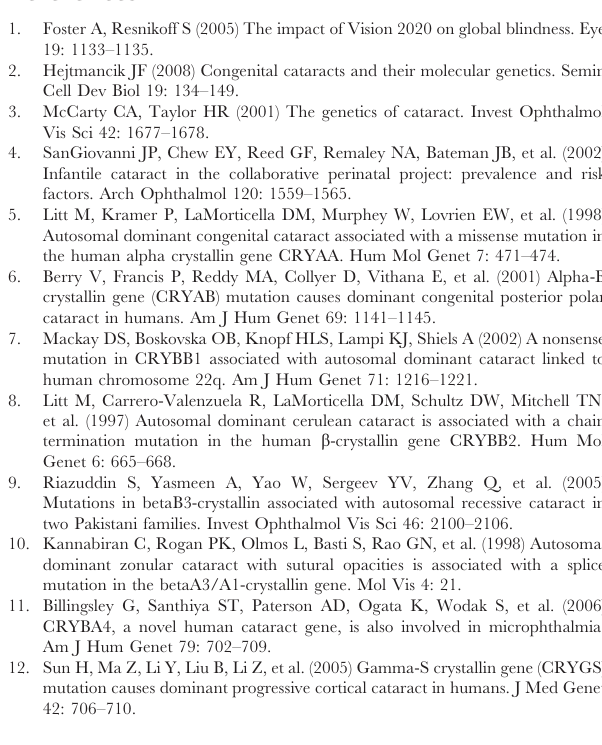
conditions at 24 or 48 hours. ***, P , 0.001; **, P , 0.01; *, P , 0.05; and ns, not significant. Values of P , 0.05 were considered to be statistically significant. Figure S5 Ligand-stimulated EPHA2 activation regu- lates Akt activation in a TN4-1 cells. ( A ) Mutant EPHA2 genes have reduced ability to activate Akt. a TN4-1 cells were grown to near confluence, and growth factor-starved for 24 hours. 2 m g/mL cross-linked ephrin-A5-Fc was then added to the starvation media and cell lysates were immunoblotted with indicated antibodies. The blot was probed with anti-phospho- Akt (Ser473), and then reprobed with anti- a -tubulin as a loading control. ( B ) Wild-type and mutant EPHA2 genes have similar activity in Akt activation when corrected for EPHA2 protein levels. Graphs show ratio of phosphor-Akt to total EPHA2. Quantification of phospho-Akt protein/total EPHA2 protein was determined using ImageJ software. Mean values are presented with + S.D as indicated. Statistical differences between multiple groups were analyzed using one-way analysis of variance (ANOVA). Values of P , 0.05 were considered to be statistically significant. ns: No statistically significant difference between the two groups. Data for the other two mutants were not quantified, due to the very low levels of the signals.